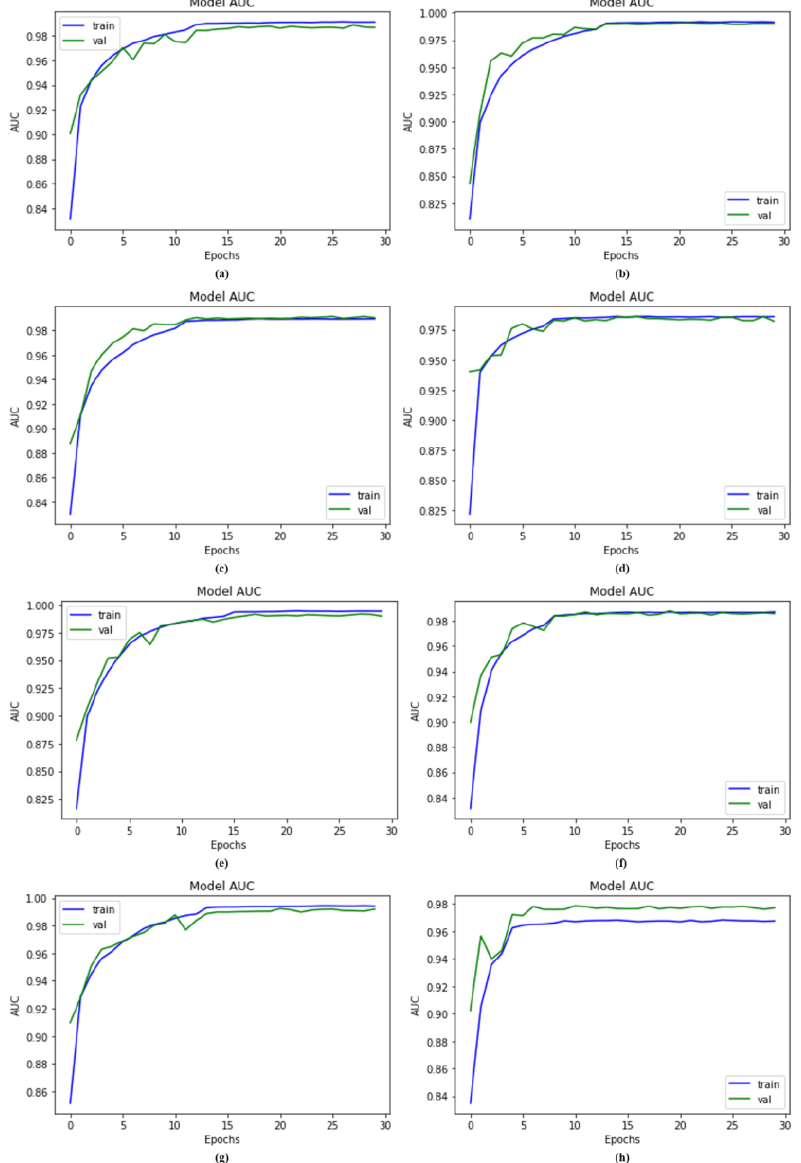
Figure 7. Results of the proposed DSCC_Net model with and without up-sampling; ( a ) Vgg-16, ( b ) Vgg-19, ( c ) EfficientNet-B0, ( d ) ResNet-152, ( e ) Inception-V3, ( f ) MobileNet, ( g ) Proposed Model with SMOTE Tomek, and ( h ) Proposed Model without SMOTE Tomek.